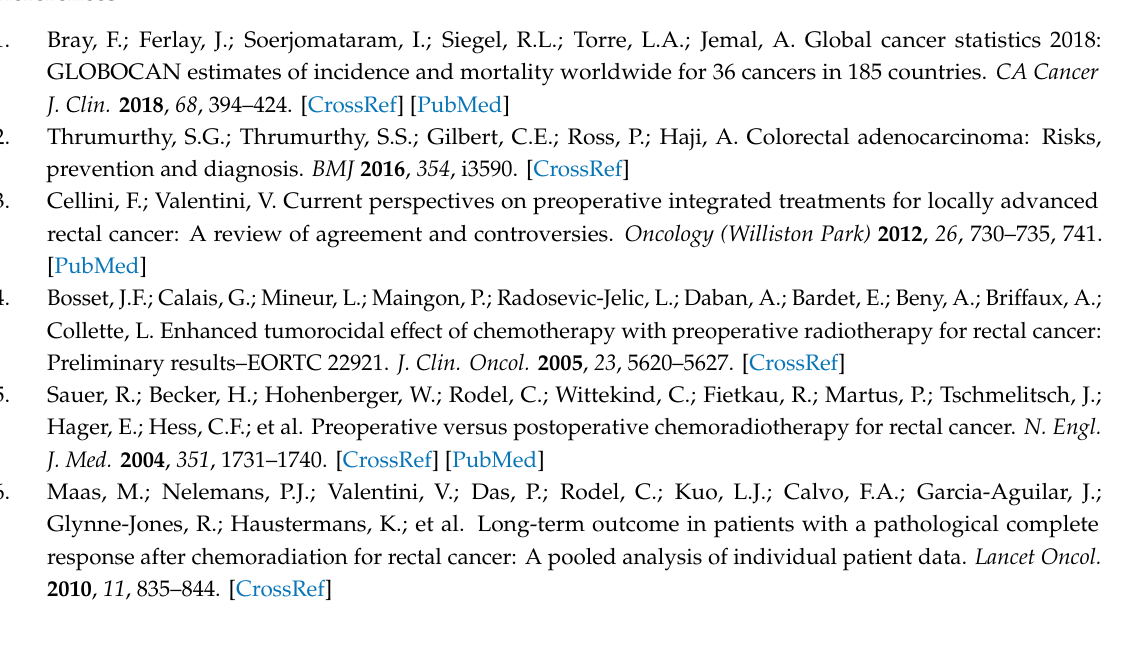
the pre-treatment biopsy and post-treatment surgical resection tumour sample, Figure S4: Consensus Molecular Subtyping of RNA data. (A) CMS by response group; (B) CMS of matched pre- and post-NACRT samples, Figure S5: Immune composition of matched pre- and post-NACRT samples Immune composition of B cells, macrophages, neutrophils, NK cells, CD4 + T cells, CD8 + T cells, and regulatory T cells identified from RNA-seq data, Table S1: Sequencing strategy summary for pre-treatment, on-treatment and post-treatment LARC samples form Beaumont Hospital (BH) and MD Anderson Cancer Centre (MDACC). XX indicates where more than one sample from di ff erent regions of the tumour was available for sequencing. *Indicates a further tumour was resected from this patient at a later date., Table S2: Significant regions of amplification and deletion from GISTIC2 analysis of pre-treatment samples at a q value threshold of 0.25, Table S3: Significant regions of amplification and deletion from GISTIC2 analysis of pre-treatment samples by response group (G vs. IP = Good versus Intermediate plus Poor; G vs. P = Good versus Poor) at a q value threshold of 0.25, Table S4: Normalised (N_score) scores of microbial abundance from pre-treatment RNA samples and sample response group, Table S5: HR-related genes (from do Canto et al.) with somatic mutations in our pre-treatment patient cohort, Table S6: The contribution of COSMIC mutational signature 3 (HR-associated) to each tumour